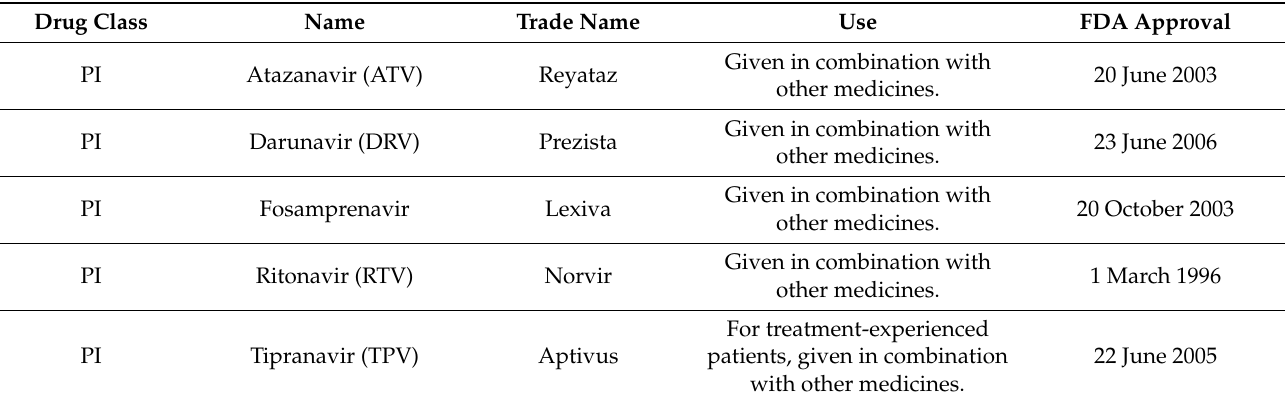
Figure 10. HIV protease structure, two-dimensional monomer map. Protease functions as a dimer and targets various host and viral proteins. HIV polyproteins are cleaved into functional units, most importantly inside maturing capsids. Several drugs interact with the active site and other coordinating amino acids such as I50 in a competitive manner, but mutations may arise that allow for continued function despite drug intervention. Based on sequence from PDB 1AID [134].